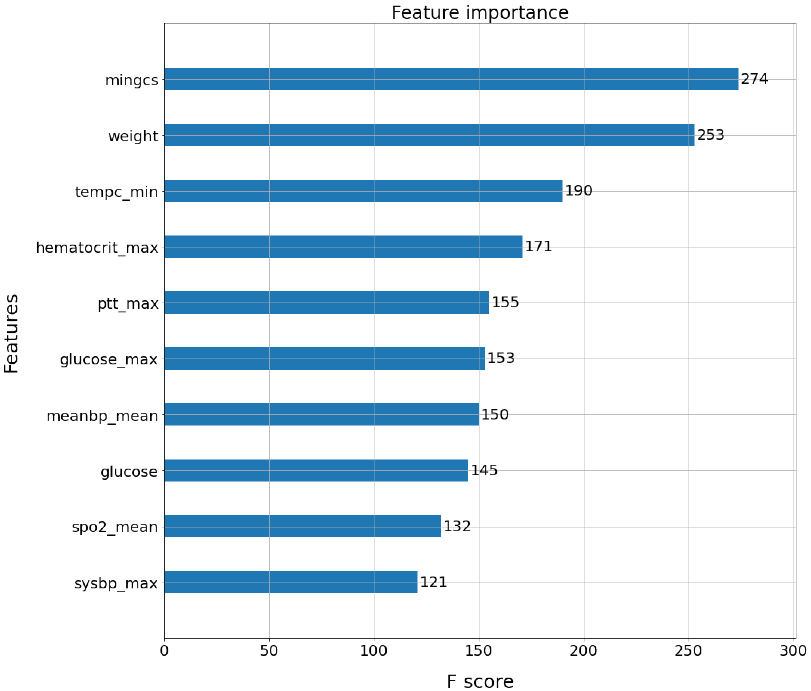
Figure 12. Feature importance for sepsis prediction using XGBoost algorithm.